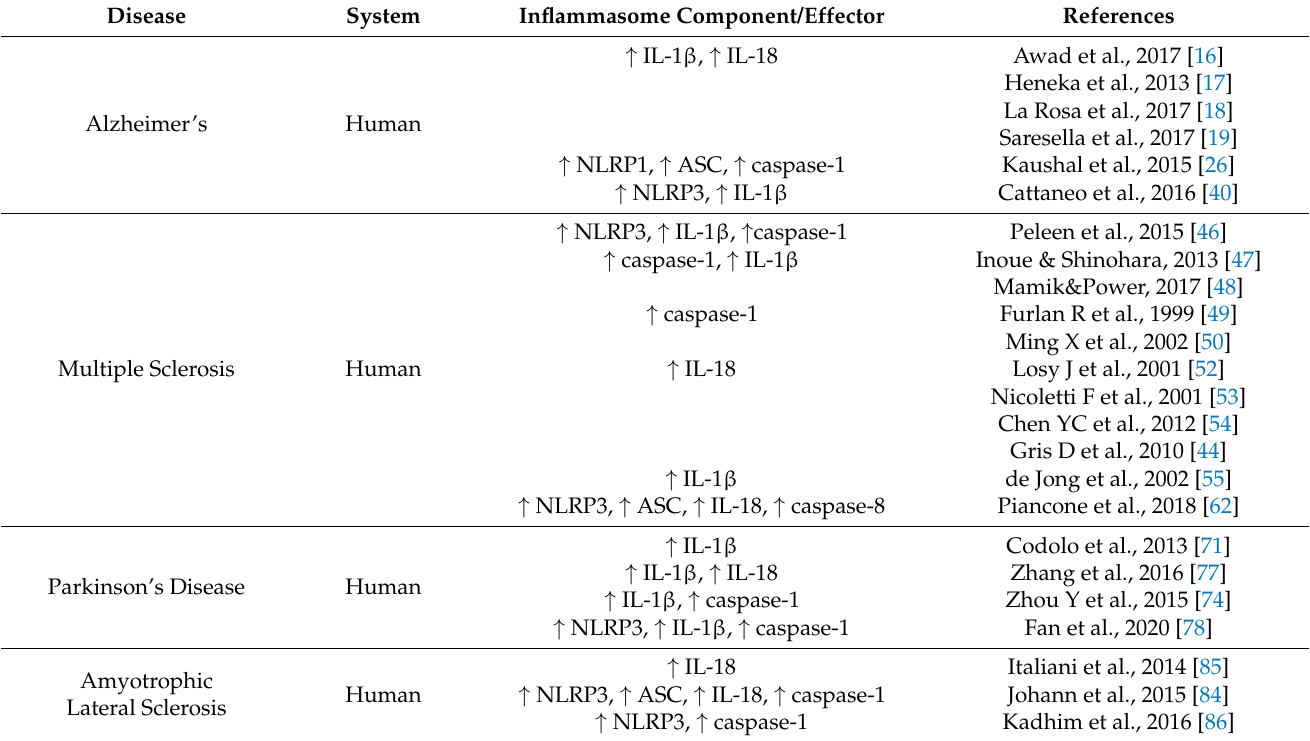
Table 1. Changes in levels of inflammasome components and effectors in cells and tissues from human samples in neurodegenerative